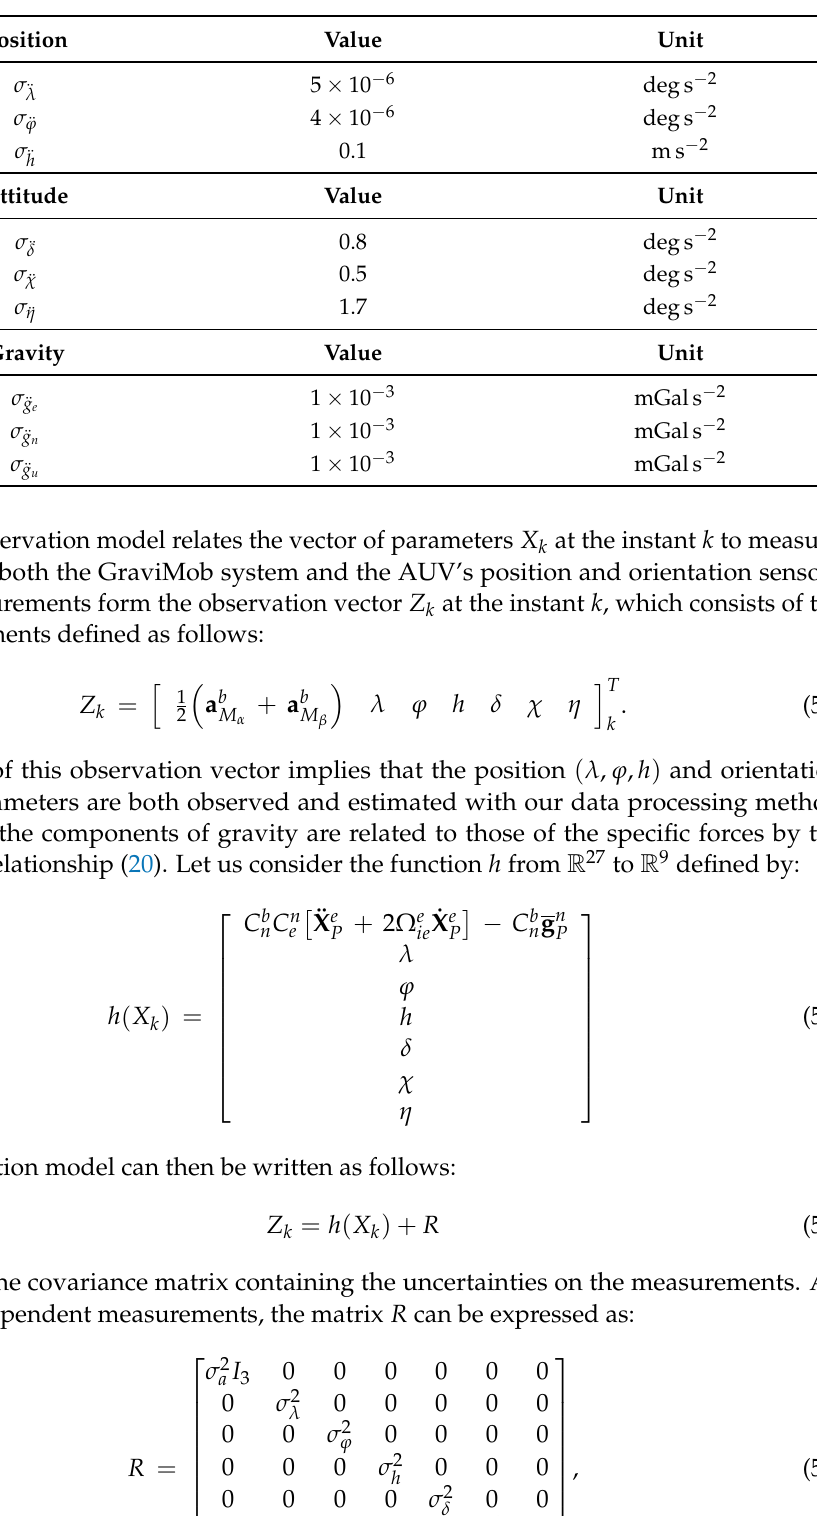
Table 4. Values of the standard deviations that enter the expression of the covariance matrix Q of the evolution model